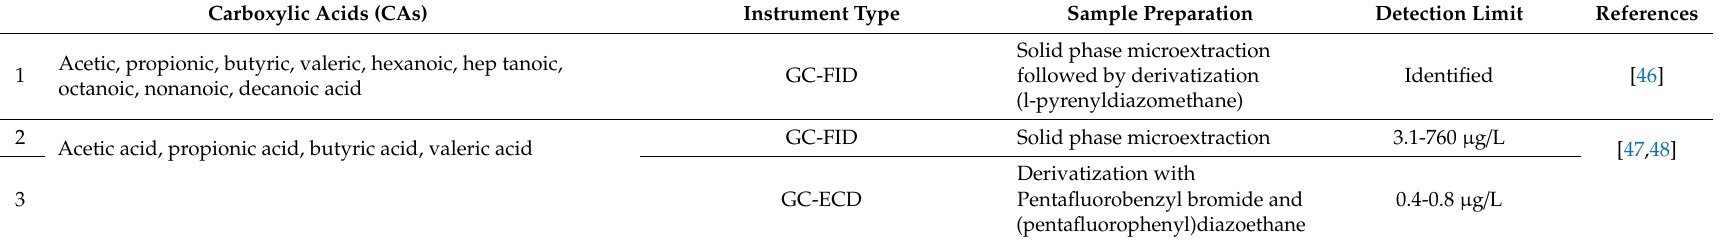
Table 2. Analytical approaches developed for detection of carboxylic acid in water